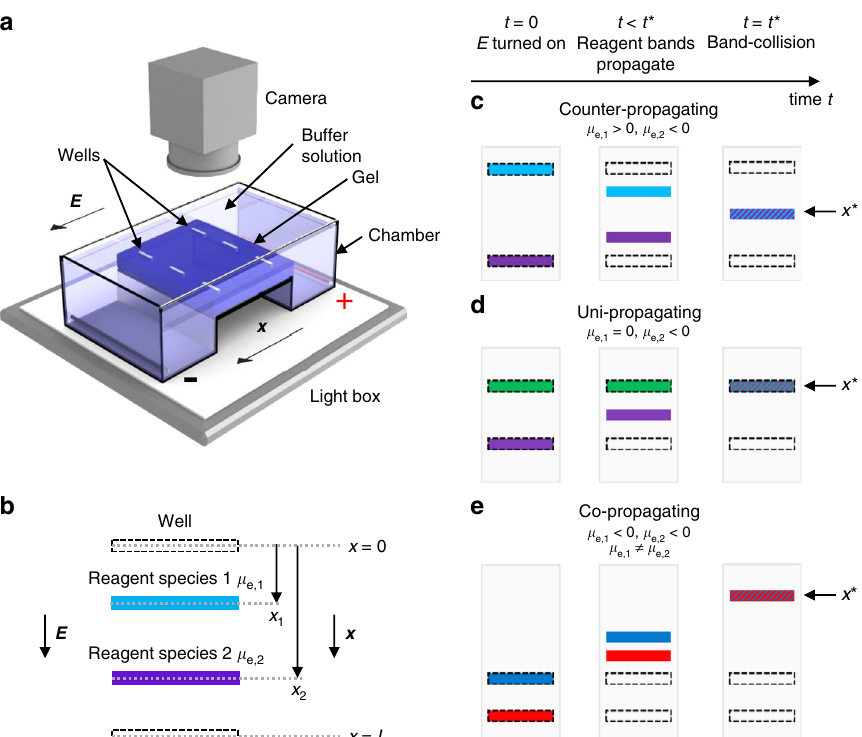
Fig. 1 Visualizing reactions between two different optically absorbing reagent species using band-collision gel electrophoresis (BCGE). a A gel having two wells per lane is cast and transferred into a transparent horizontal gel electrophoresis chamber fi lled with a buffer solution at a desired pH. Pt-wires near the ends of the chamber, designated by black ( − ) and red ( + ), are connected to a power supply (not shown). Each well is loaded with a different reagent species, and the power supply, which generates an electric fi eld E that lies along the x -direction, is turned on at time t = 0. A light box underneath the chamber provides uniform transmission illumination of white visible light, and time-lapse images are captured by an overhead camera with a lens selected to minimize spatial distortion. b Overhead view depicting the center locations x 1 ( t ) and x 2 ( t ) of propagating bands of reagent species 1 (blue band) and 2 (purple band), respectively, in a lane at time t ; both x 1 and x 2 are referenced relative to the well centered at x = 0. Reagent species 1 and 2 were initially loaded into the wells centered at x = 0 and x = L , respectively. Here, the electrophoretic mobilities of reagent species 1 and 2 have μ e,1 > 0 and μ e,2 < 0, respectively. c – e Each panel shows the evolution of bands in a single lane containing two wells during BCGE for different μ e,1 and μ e,2 (see the Methods section): (left) at time t = 0 when E is turned on, (middle) at some time later t < t * before band collision, and (right) full band collision at t = t *,